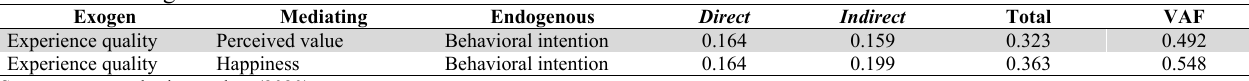
Results of Testing the Role of